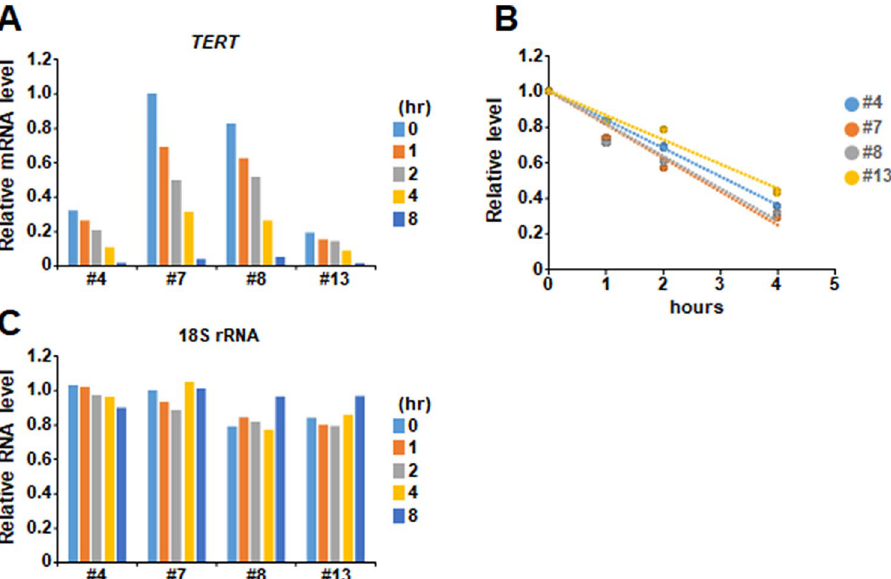
Figure 2. Stability of the TERT mRNA was not so different between WT and TAF-I KD cells. ( A , C ) The expression level of TERT mRNA in WT and TAF-I KD cells which were treated with actinomycin D was examined by Q-RT-PCR analyses. WT and TAF-I KD cells treated with actinomycin D for 1, 2, 4 and 8 h were collected and subjected to total RNA purification. Each cell just before treating with actinomycin D was also collected as a 0 h sample. Q-RT-PCR analyses were performed with each purified total RNA to examine the expression level of TERT mRNA and 18S rRNA. Relative expression level of TERT mRNA and 18S rRNA was plotted as indicated graphs ( A , C ), respectively. ( B ) The value of TERT mRNA was normalized by dividing it with that of 18S rRNA. Each relative value when the normalized value of 0 h sample was set to be 1.0 was